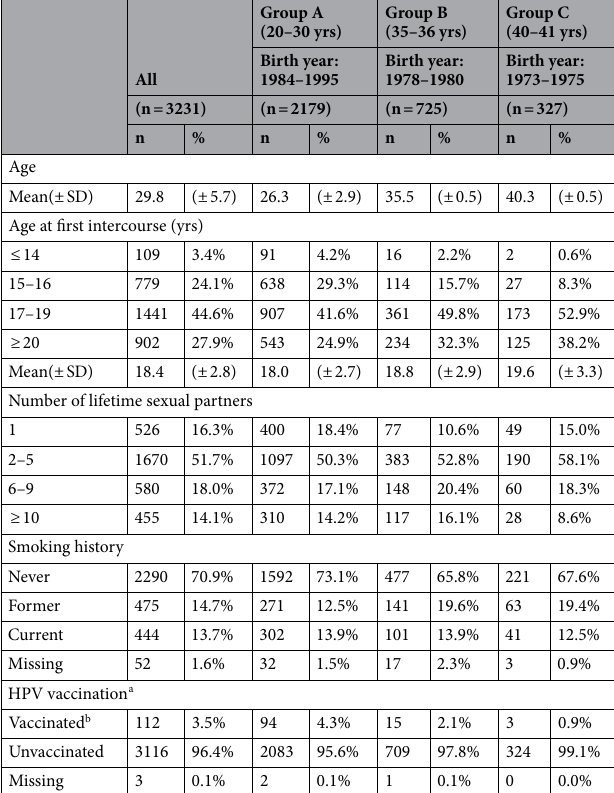
Table 1. Background of the participants. a Self-reported. b Bivalent or